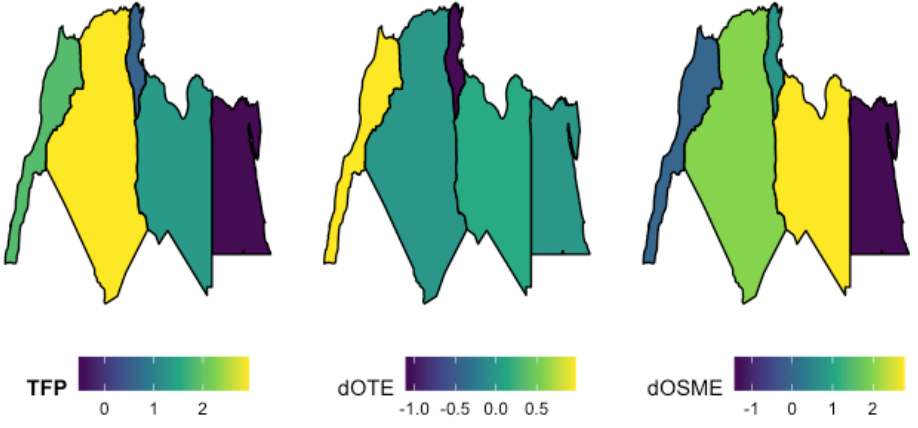
Figure 2. Agricultural productivity growth in North Africa as shown by TFP and components of TFPE, 2000–2016. Note: dTFP = Productivity Change, dOTE = Technical Efficiency Change and dOSME = Scale-Mix